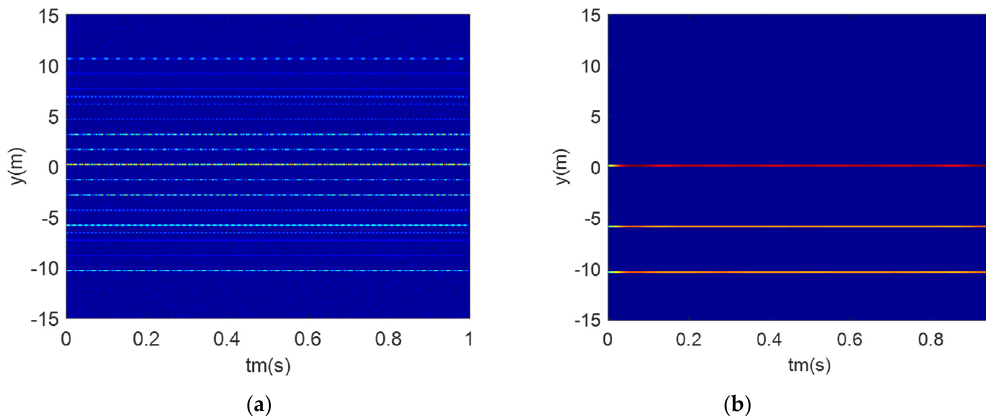
Figure 5. The spatial spectrums of radar echoes. ( a ) Conventional method. ( b ) Our method.